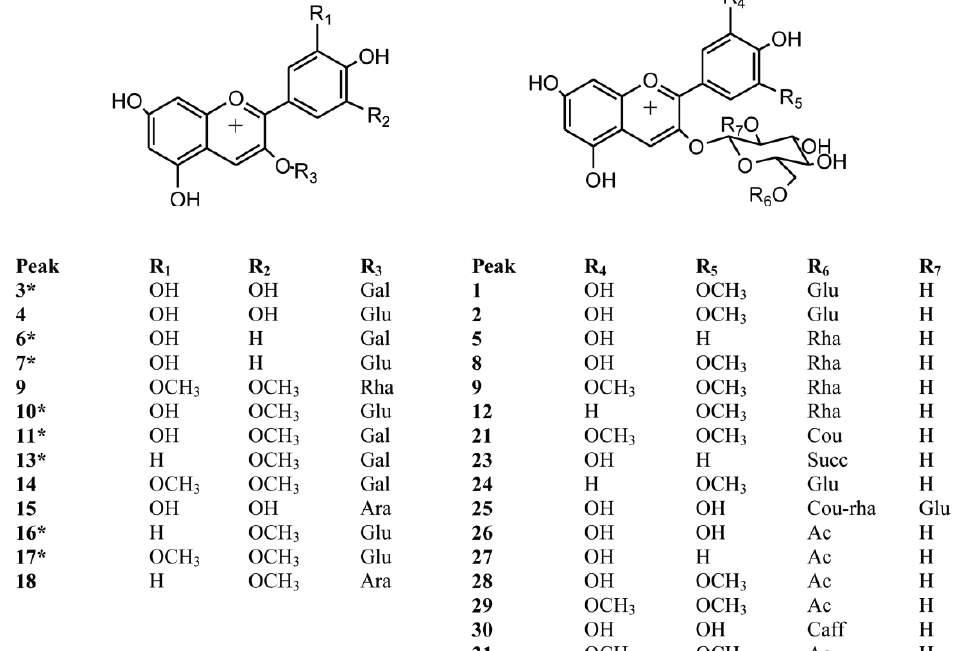
Figure 3. Structures of the anthocyanins identified in six berries from the VIII region of